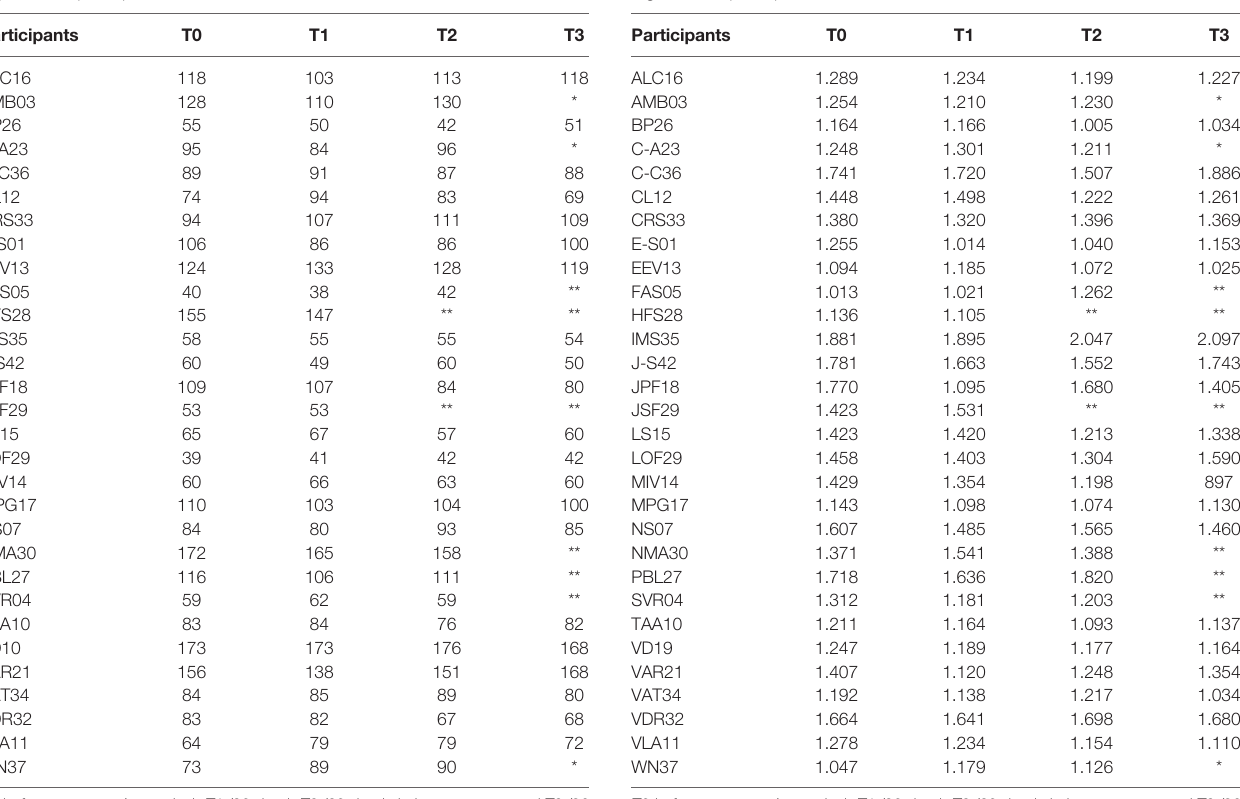
TABLE 6 | Evaluation of the plasma concentration of Immunoglobulin G (IgG) in mg/dL of 30 participants # at T0, T1, T2, and